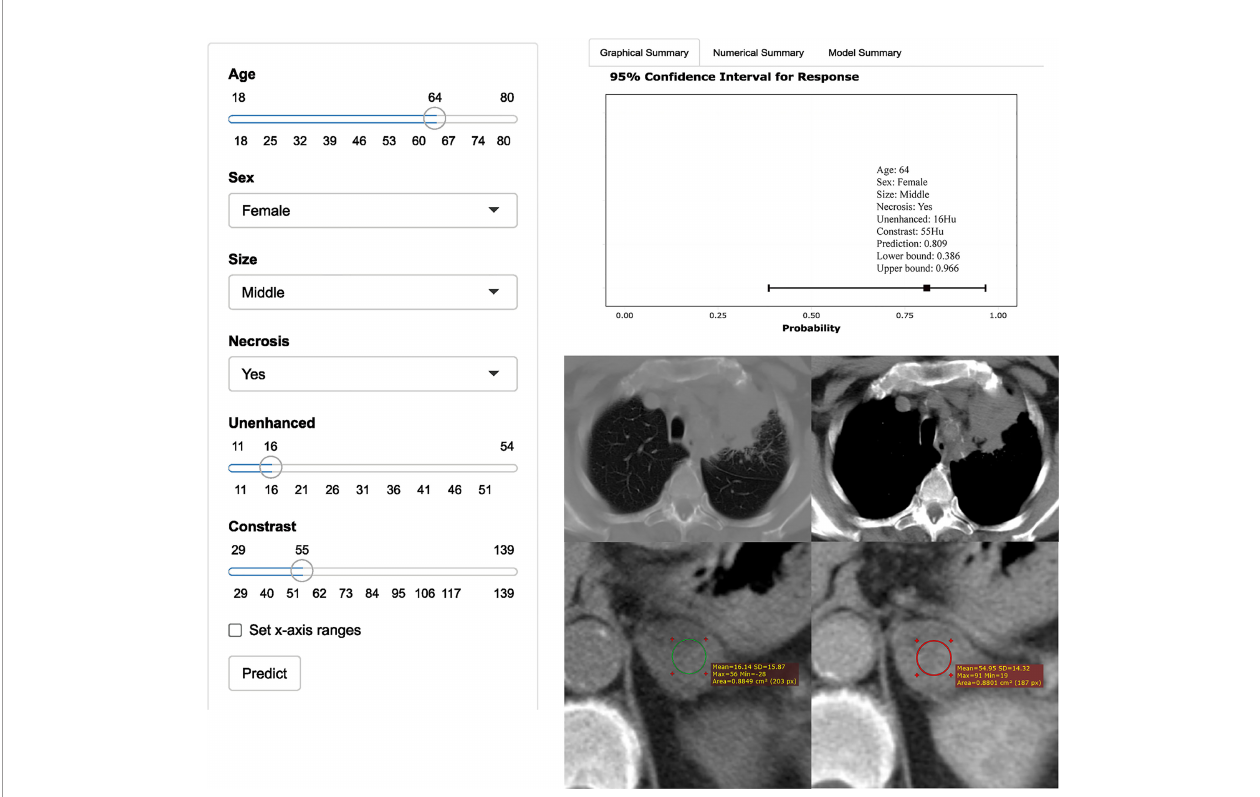
FIGURE 3 | Axial unenhanced and contrast-enhanced adrenal CT images in a 64-year-old woman with cough and expectoration. The woman was accidentally found having left adrenal lesions due to chest CT fi ndings of left upper lung mass and multiple lymph nodes in the left hilar and mediastinum. CT features were analyzed as follows: lesion location = “ left ” , size = “ middle (2.7cm×2.1cm) ” , shape = “ quasi-circular ” , unenhanced attenuation = 16 HU, contrast-enhanced attenuation = 55 HU, and necrosis= “ yes ” . Both radiologists evaluated that the possibility of nonadenoma (metastasis) was high, while the possibility of adenoma judged by the model was up to 81% (95% CI: 39%, 97%). The result of pathological diagnosis was adrenal